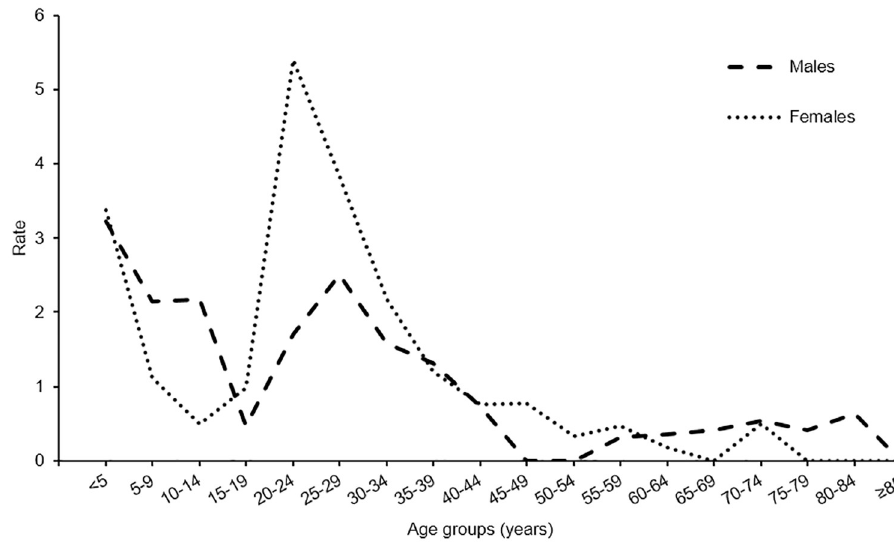
Fig 2. Number and average annual crude incidence rate of cases by age group and sex, 2016–2017. Average annual crude incidence rate for 100,000 population.